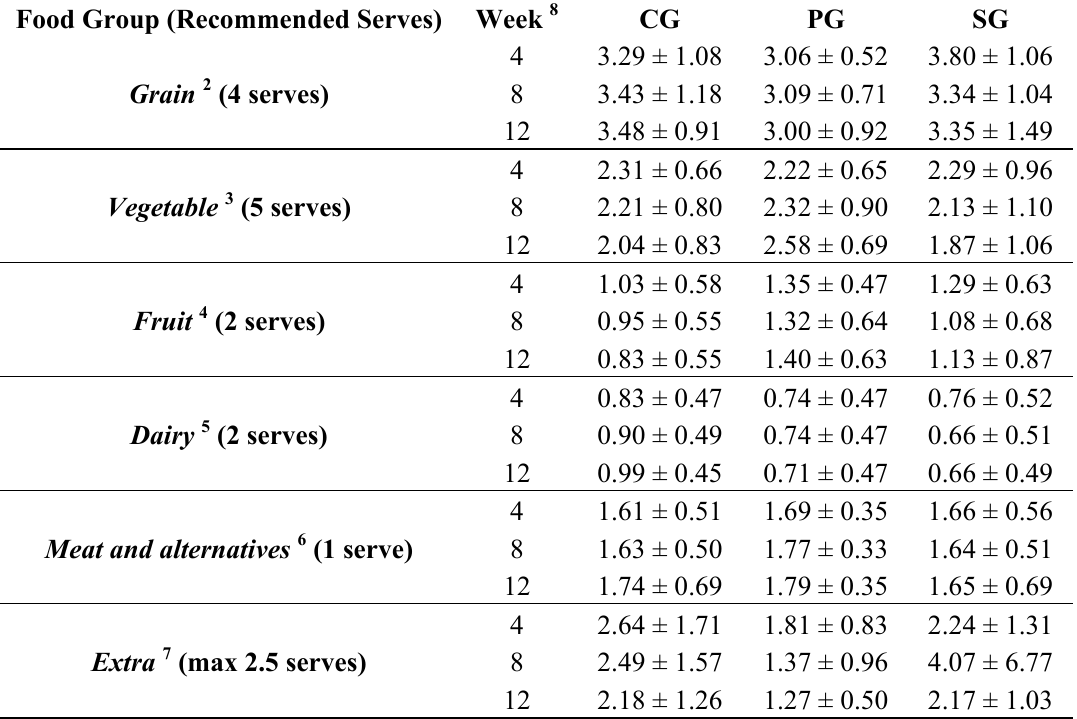
Table 1. Number of serves 1 consumed by participants in the control (CG), pork diet (PG) and supplement (SG) groups during each collection